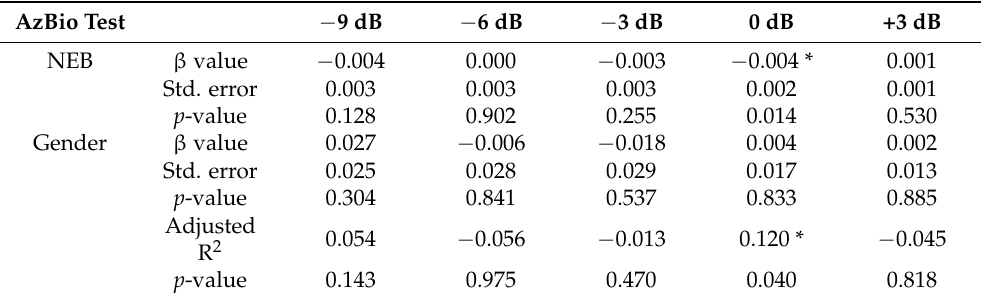
Table 6. Results of the regression analyses listing predictors for performances in the AzBio test at five